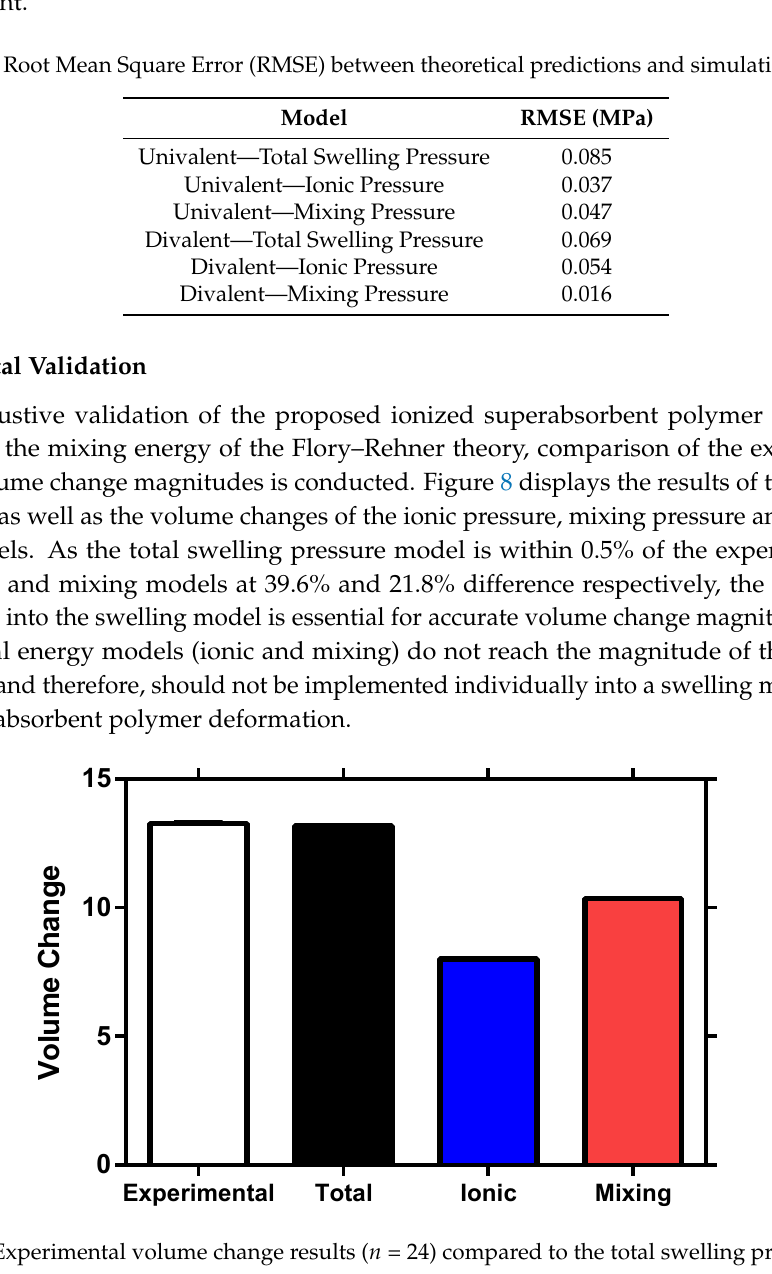
Figure 8. Experimental volume change results ( n = 24) compared to the total swelling pressure, ionic pressure and mixing pressure models in a univalent solution. The total swelling model shows greatest fit with experimental data, hence validating the addition of the mixing energy to the ionized hydrogel numerical swelling